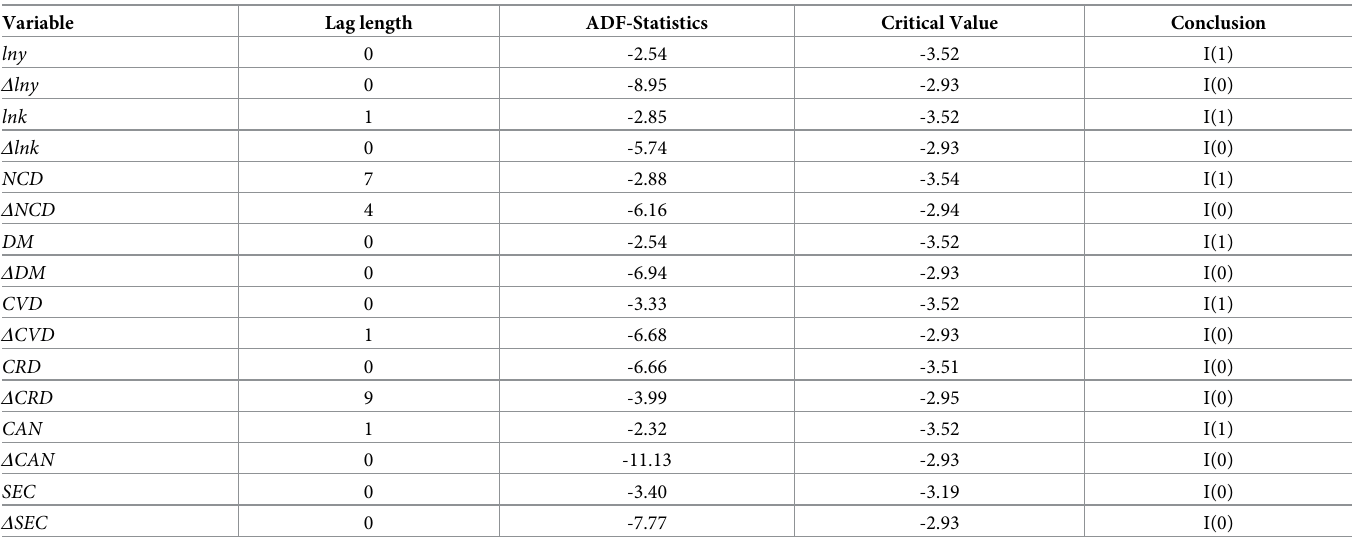
Table 3. Unit root test.